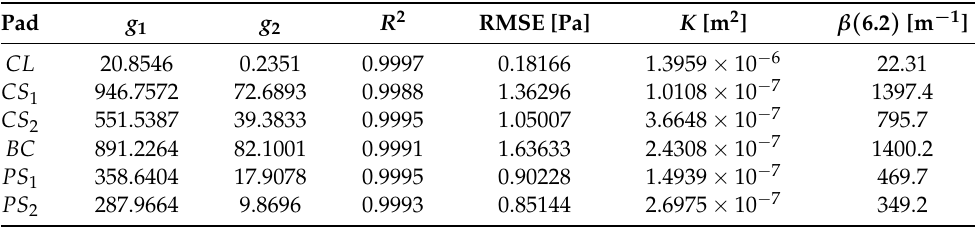
Table 12. Permeability ( K ) and coefficients used to compute the Forchheimer coefficient as a function of water flow ( β ( Q ) = ( g 1 + g 2 Q ) ) in Equation (5). The coefficient of determination ( R 2 ) and the Root Mean Square Error (RMSE [Pa]) of the fitted equation are presented. The Forchheimer coefficient for a water flow of 6.2 L min − 1 m − 1 for comparison purposes is also